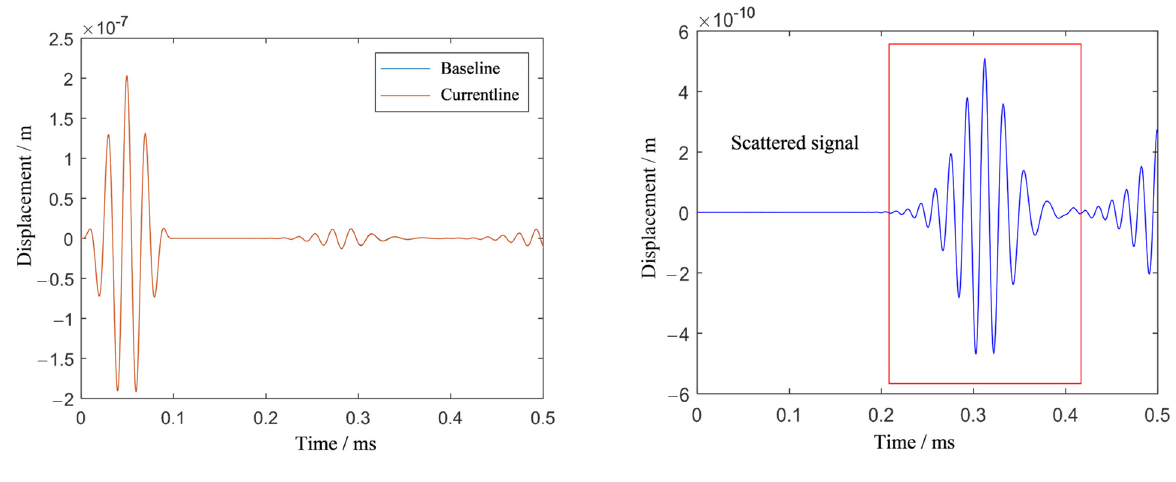
Figure 3. The effect of damage on the signals in Case I.